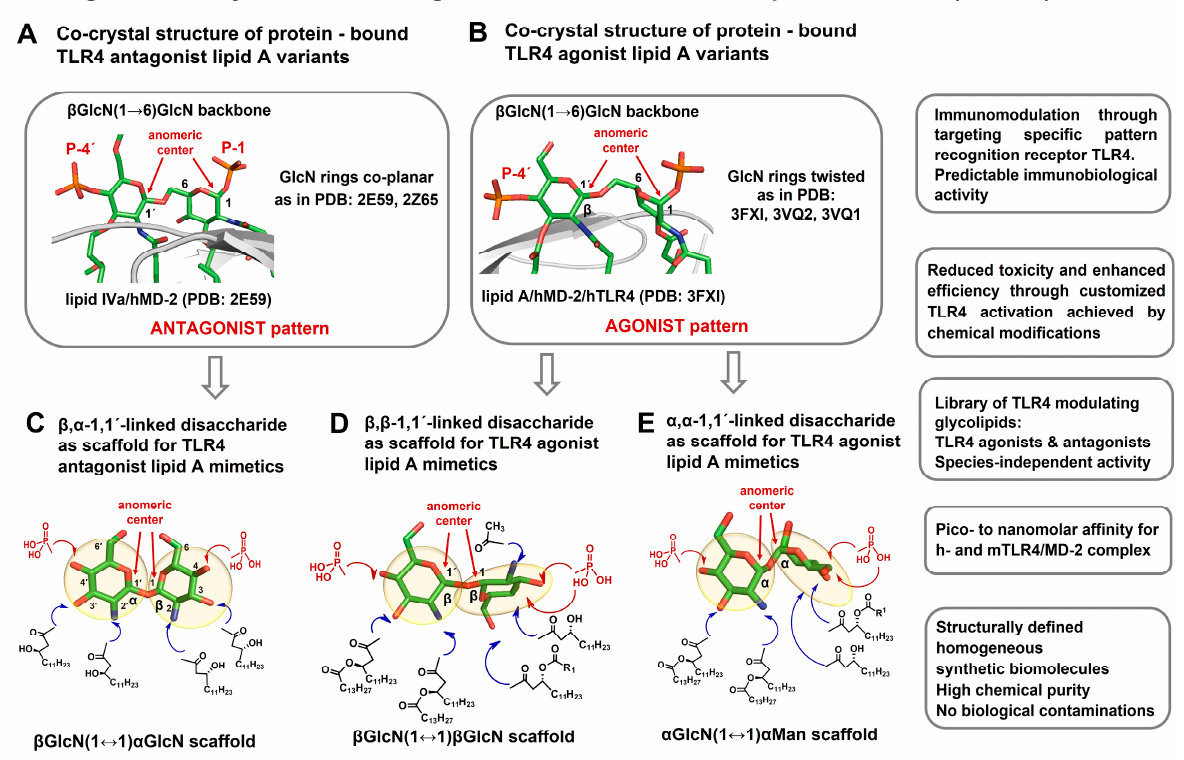
Figure 6. Co-crystal-structure-based design of disaccharide lipid A mimetics (DLAMs). ( A ) The co-crystal structures of hMD-2-bound lipid IVa and Eritoran (PDB codes: 2E59 and 2Z65, respectively) disclose a co-planar relative orientation of two GlcN rings comprising the β (1 → 6)-linked diglucosamine backbone of lipid A. This arrangement is achieved through rotation about flexible β (1 → 6) linkage. A specific co-planar relative orientation of the GlcN rings in a β GlcN(1 → 6)GlcN backbone in a protein-bound lipid A is designated an “antagonist pattern”. ( B ) The co-crystal structures of hMD-2/TLR4-bound E. coli lipid A (PDB code: 3FXI), mMD-2/TLR4-bound E. coli lipid A (PDB code: 3VQ2), and mMD-2/TLR4-bound lipid IVa (PDB code: 3VQ1) reveal a skewed relative orientation of two GlcN rings in the β (1 → 6)-linked diglucosamine backbone of protein-bound lipid A. This relative orientation of GlcN rings achieved through rotation about β (1 → 6) linkage is designated an “agonist pattern”. ( C ) Design of TLR4 antagonist lipid A mimetics. The co-planar molecular shape of β , α -1,1 (cid:48) -linked diglucosamine mirrors the 3D-topology of the β GlcN(1 → 6)GlcN backbone of hMD-2-bound TLR4 antagonists shown in ( A ). The sites of attachment of the lipid chains and phosphate groups for the synthesis of lipid A mimetics are represented by blue and red arrows, respectively. ( D ) Design of TLR4 agonist lipid A mimetics based on a β , β -1,1 (cid:48) -diglucosamine